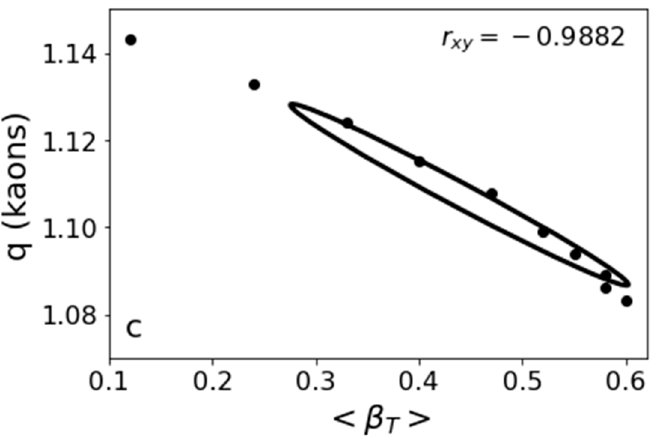
Figure 7. The q (pions) versus (cid:104) β T (cid:105) ( a ), q ((anti)protons) versus (cid:104) β T (cid:105) ( b ), and q (kaons) versus (cid:104) β T (cid:105) ( c ) dependencies, obtained using Equation (5) and presented in Table 2. The corresponding 1-sigma confidence ellipses and Pearson correlation coefficients are also shown in the figures.